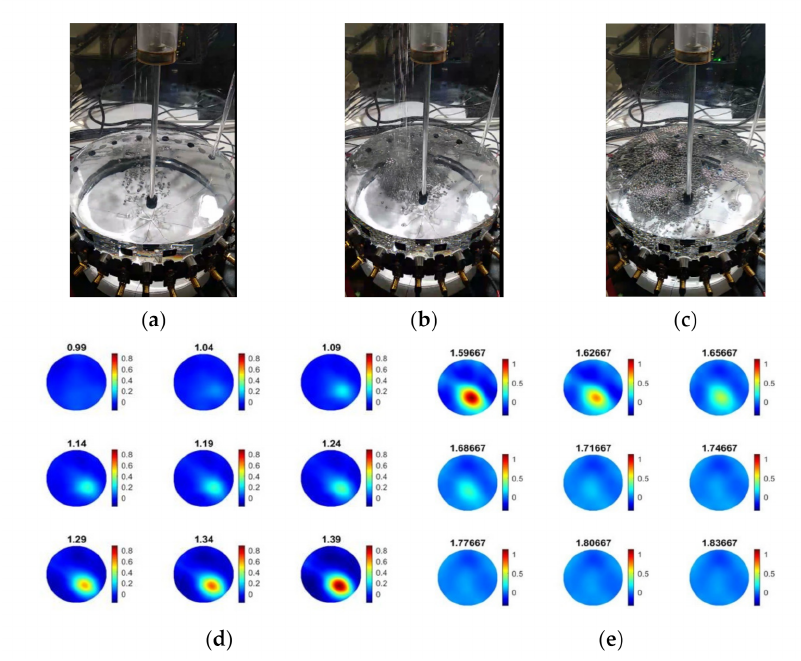
Figure 5. Addition of 100 g of particle beads in 3 L of water: ( a – c ) experimental photos demonstrating the pouring location and the mixing (200 RPM); ( d ) reconstructions between 0.99 min and 1.39 min, ( e ) reconstructions between 1.6 min and 1.84 min that corresponds to terminating the time of the addition of the particles and the settling period.